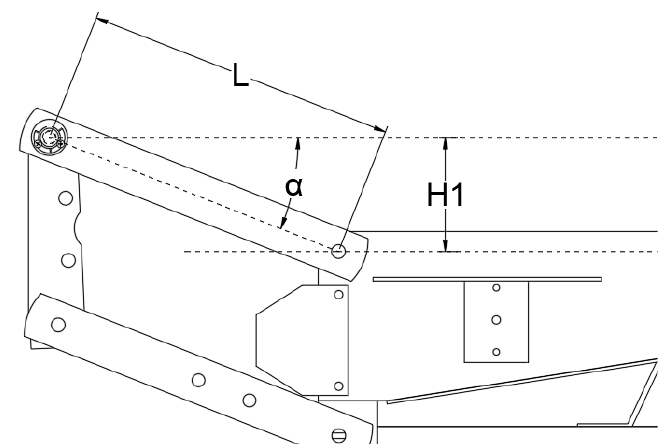
Figure 2. Inclination detection diagram of the parallel four-bar linkage.